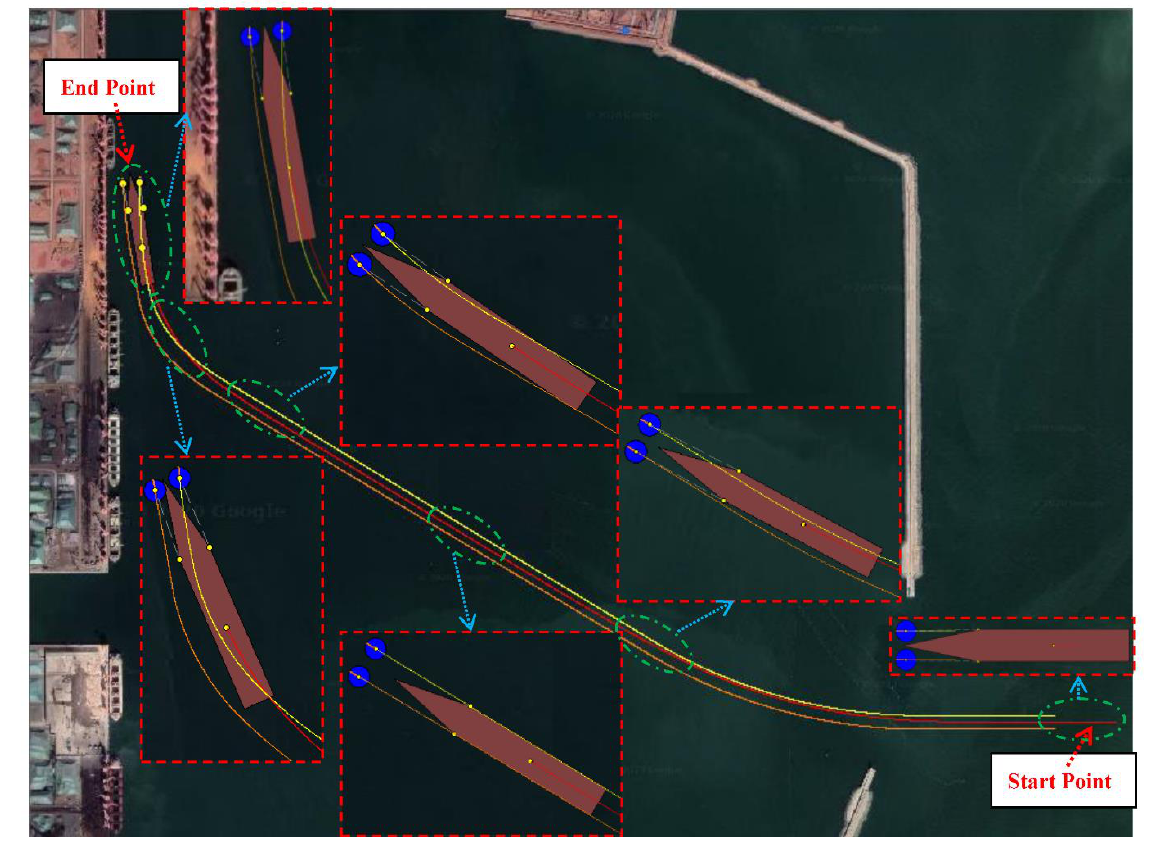
Figure 16. Motion process diagram of multi-tug-assisted ship towing.